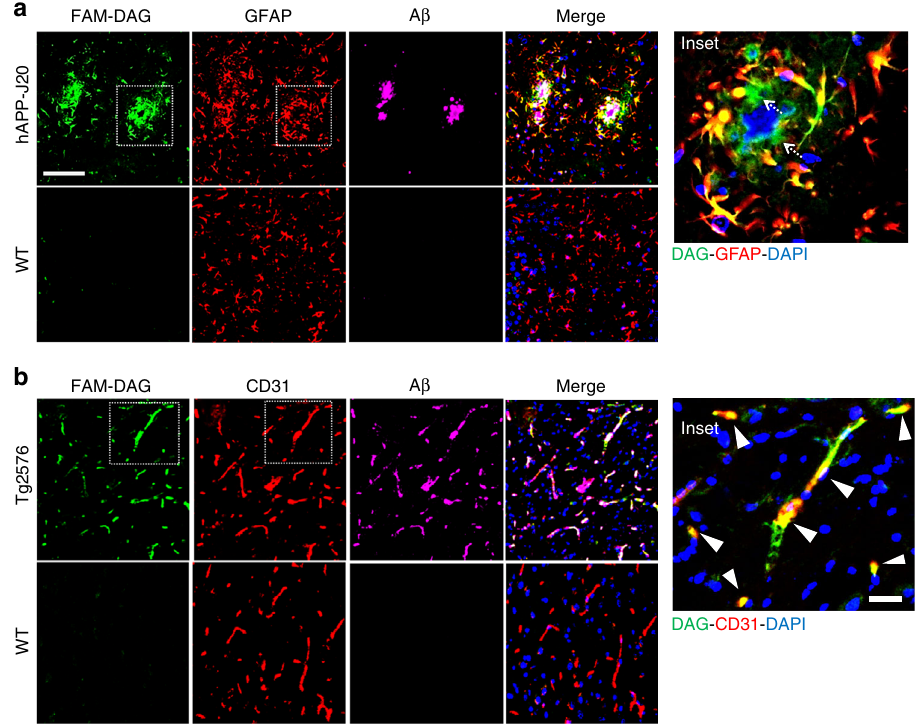
Fig. 2 Homing of DAG peptide to the brains of AD model mice. a DAG targets activated astrocytes in AD mouse brain. a FAM-DAG was intravenously injected to 9-month-old hAPP-J20 and WT mice and allowed to circulate for 30 min. The mice were perfused, and the brains were fi xed, sectioned and stained for FAM in DAG ( green ), GFAP ( red ) and A β ( magenta ). The region shown is the hippocampus. The inset shows co-localization between DAG and GFAP, and also DAG + and GFAP - regions ( arrows ). b DAG targets vessels positive for A β in Tg mice b . DAG was injected intravenously to 20-month-old Tg2576 WT mice, and processed as in panel a . The brain sections were stained for FAM ( green ), CD31 ( red ) and A β ( magenta ). The region shown is the cortex. The inset shows co-localization of DAG and CD31 ( yellow , white arrowheads ). Scale bars , 50 µ m ( a and b ), 20 µ m ( insets